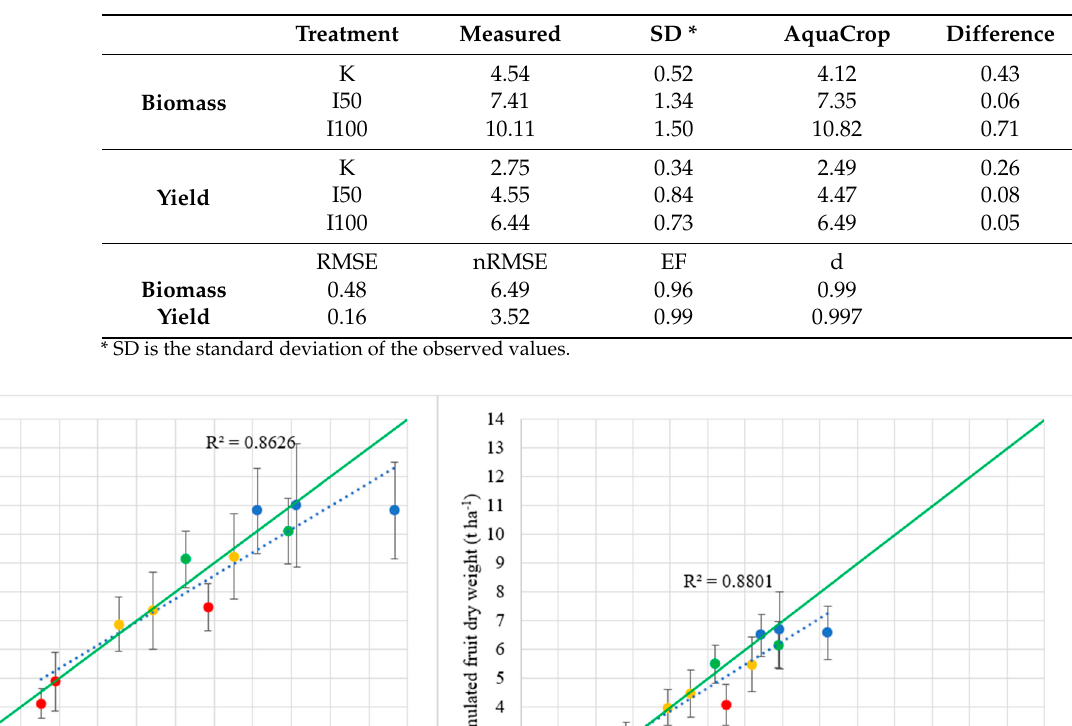
Table 6. Simulated and measured dry biomass and yield values (t ha − 1 ) for 2017 (validation) with the modelling evaluation parameters.